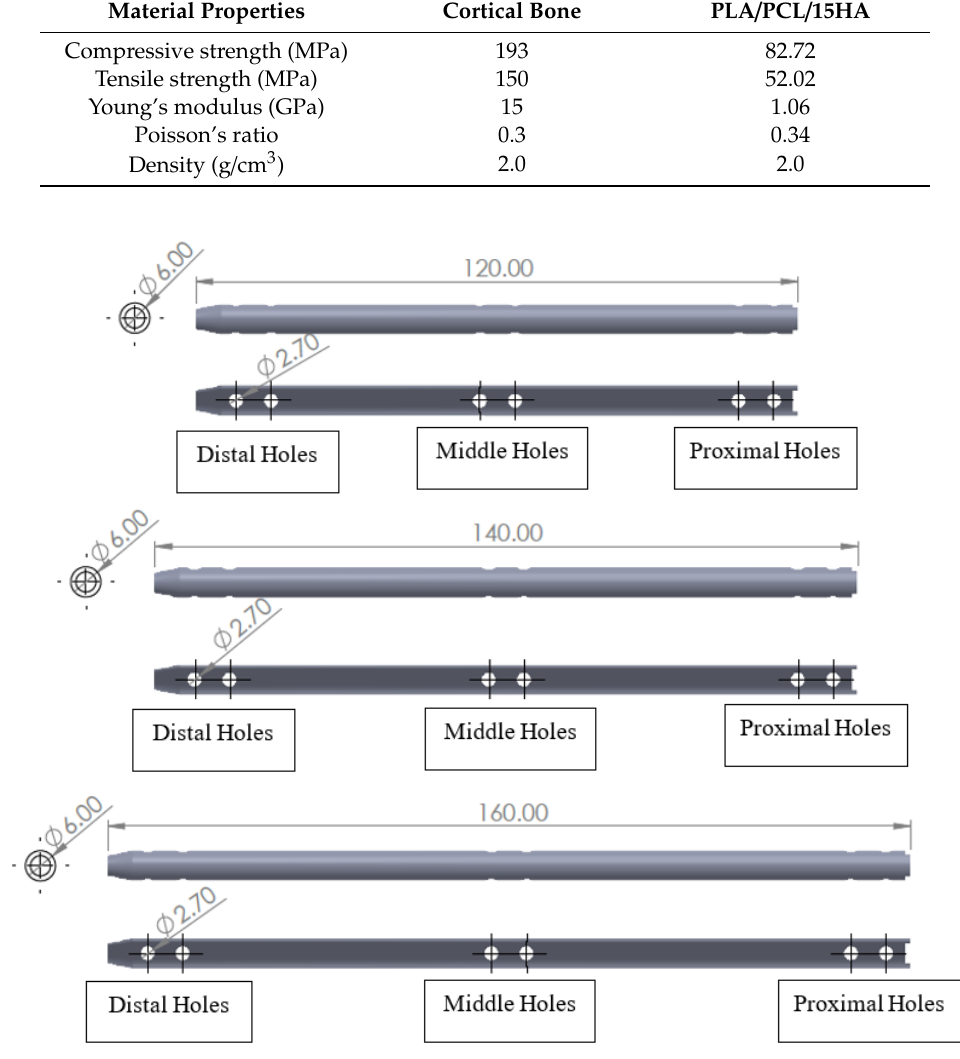
Figure 4. The holes ’ positions and three lengths of the composite interlocking nail. Figure 4. The holes’ positions and three lengths of the composite interlocking